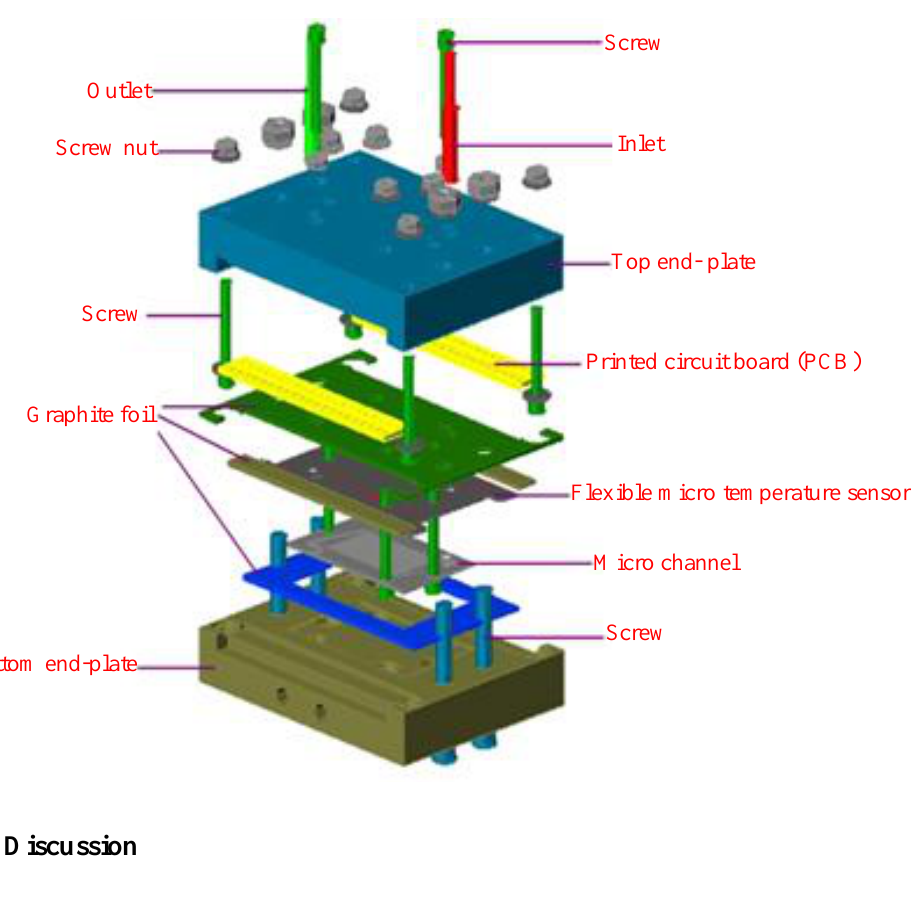
Figure 7. Structure of the micro reformer combined with flexible micro temperature